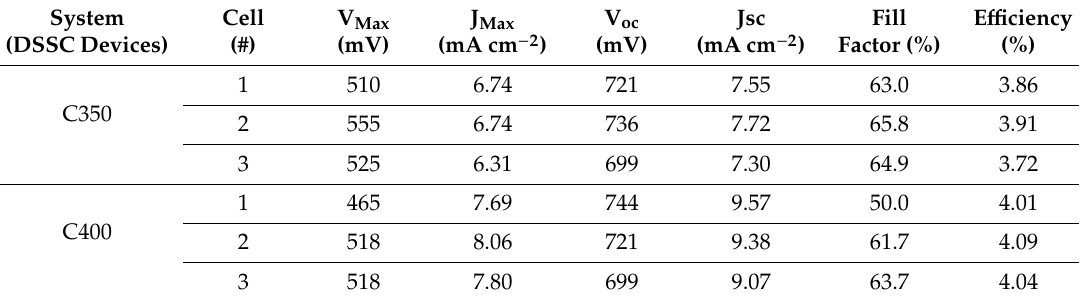
Figure 8. J-V curves of ( a – c ) Conventionally sintered titania-based DSSCs, ( d – f ) Microwave sintered titania-based DSSCs. Table 3. J-V parameters of the